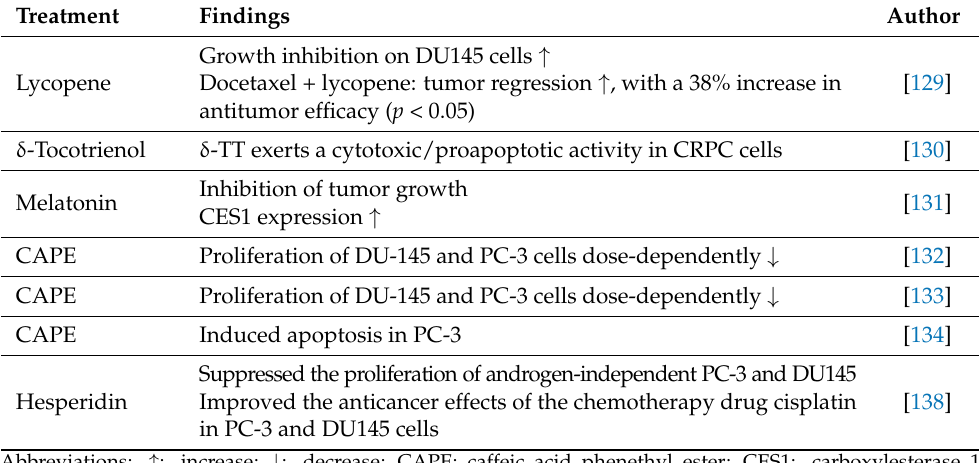
Table 4. Application of antioxidants in castration-resistant prostate cancer